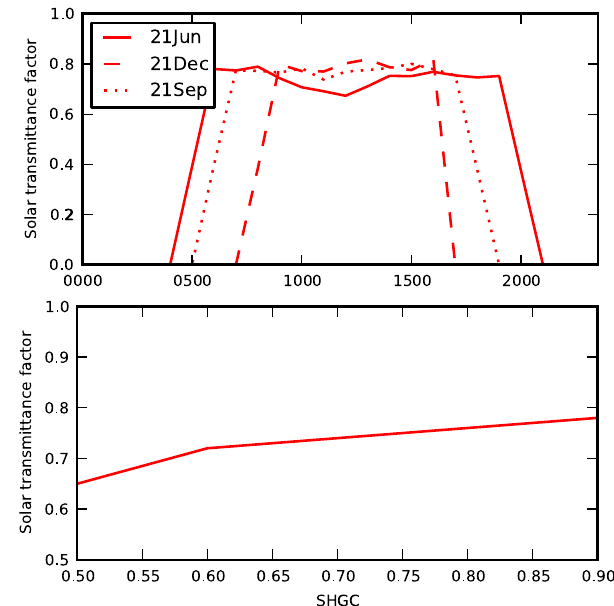
Fig. A1. Diurnal cycle of the solar transmittance factor of a win- dow with a SHGC=0.8 (top) and daytime-average solar transmit- tance factor for different SHGC (bottom). The solar transmittance factor is defined as the ratio between the average of the solar trans- mittances for different window orientations and the SHGC. In the first graph, three characteristic days of the year are represented, the two solstices and an